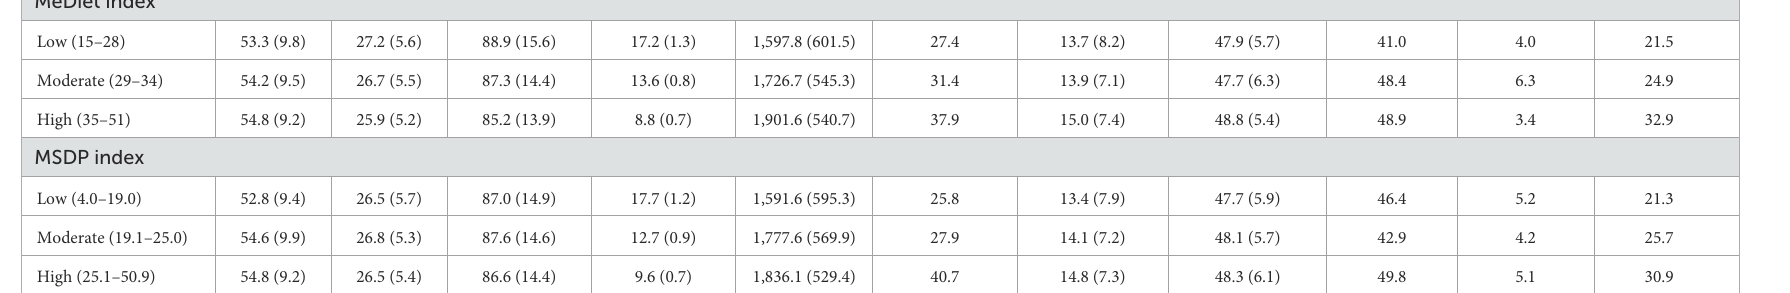
Age at menopause b (years)